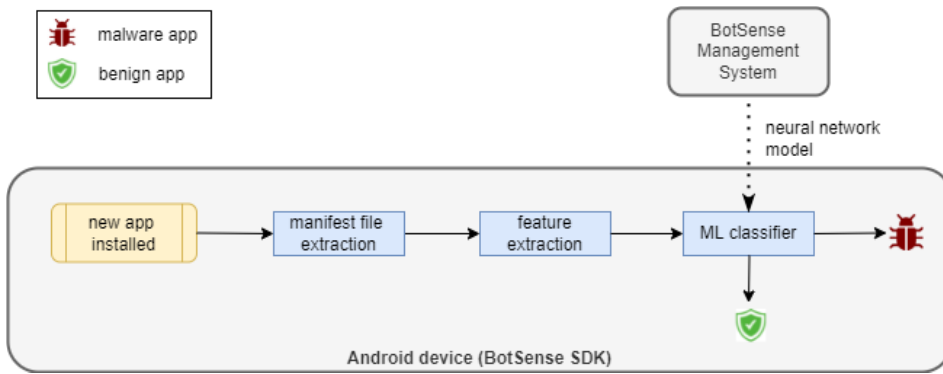
Figure 6. The process of assessing a newly installed application as malicious or